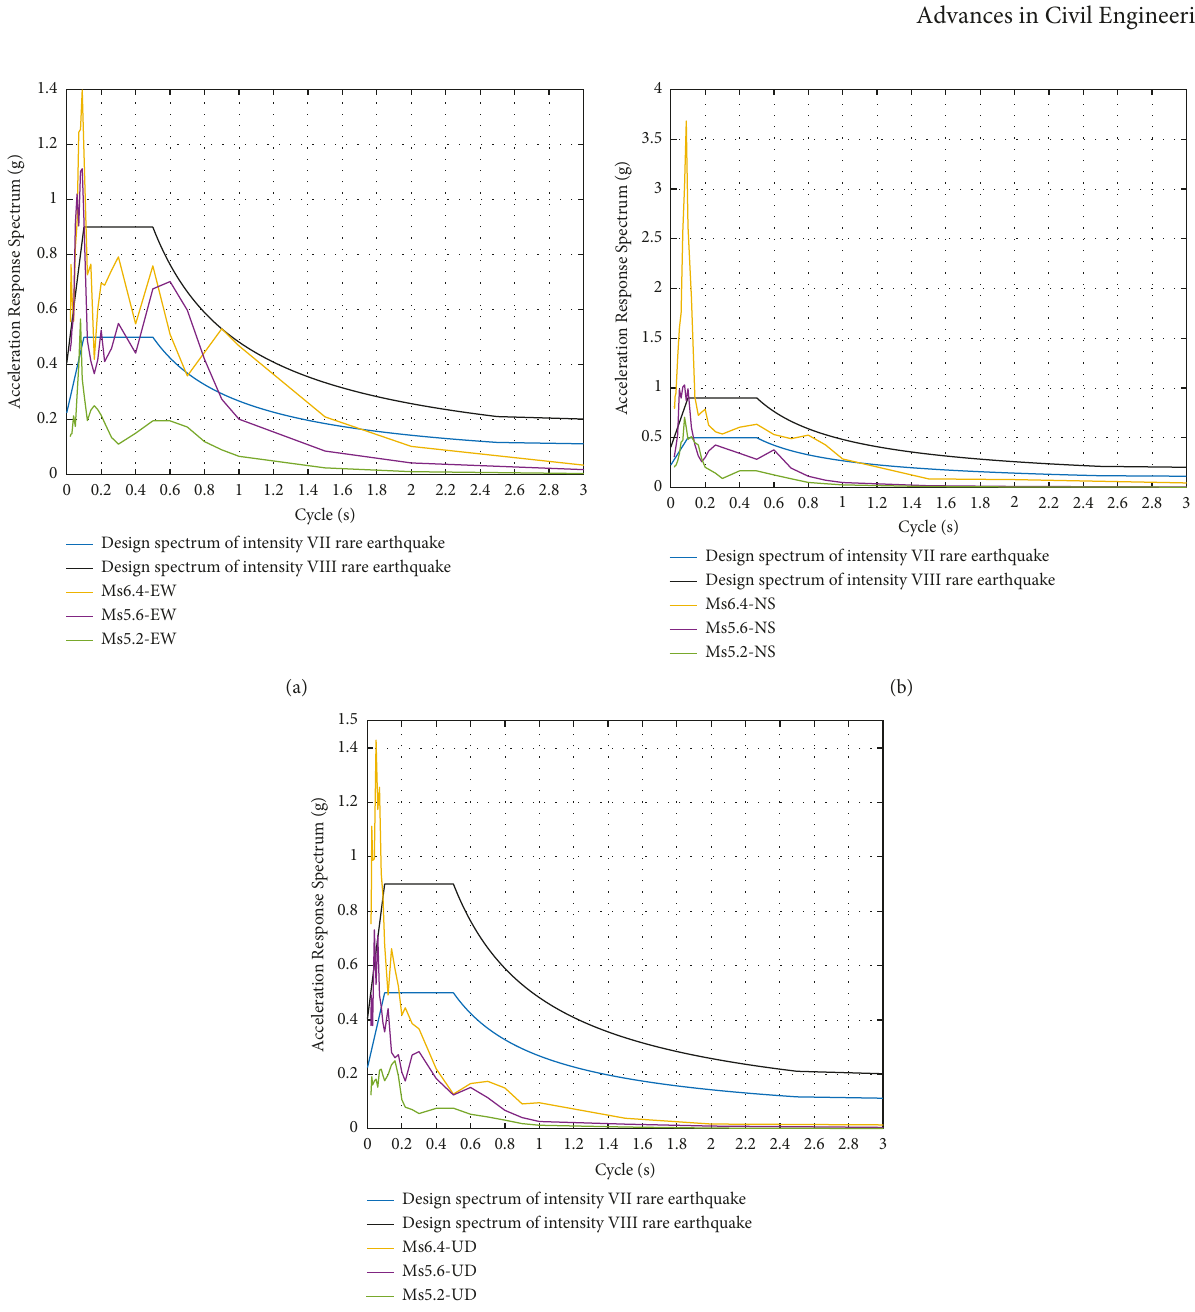
Figure 6: Comparison of acceleration response spectra (Sa) and code design spectra among the MS6.4, MS5.6, and MS5.2 earthquakes: (a) east-west; (b) north-south; and (c)